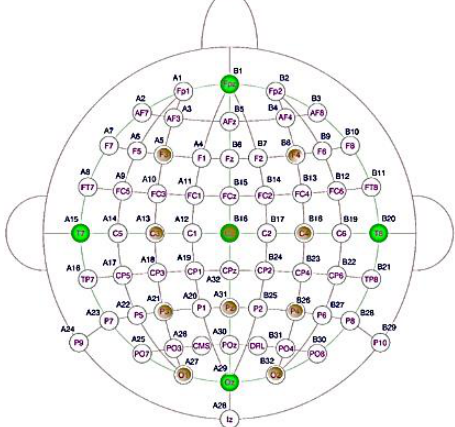
Figure 2. International 10-20 electrode placement system with the selected 10 channels in